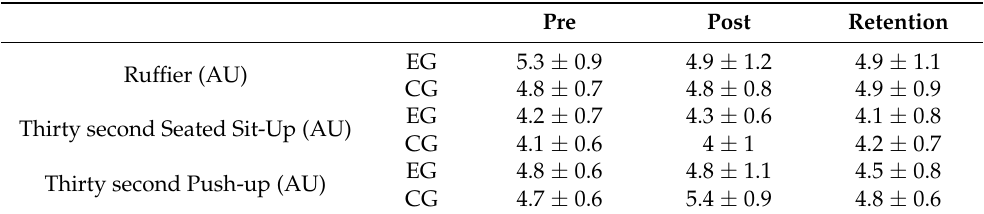
Table A2. Results of the CFT’s RPE analysis.